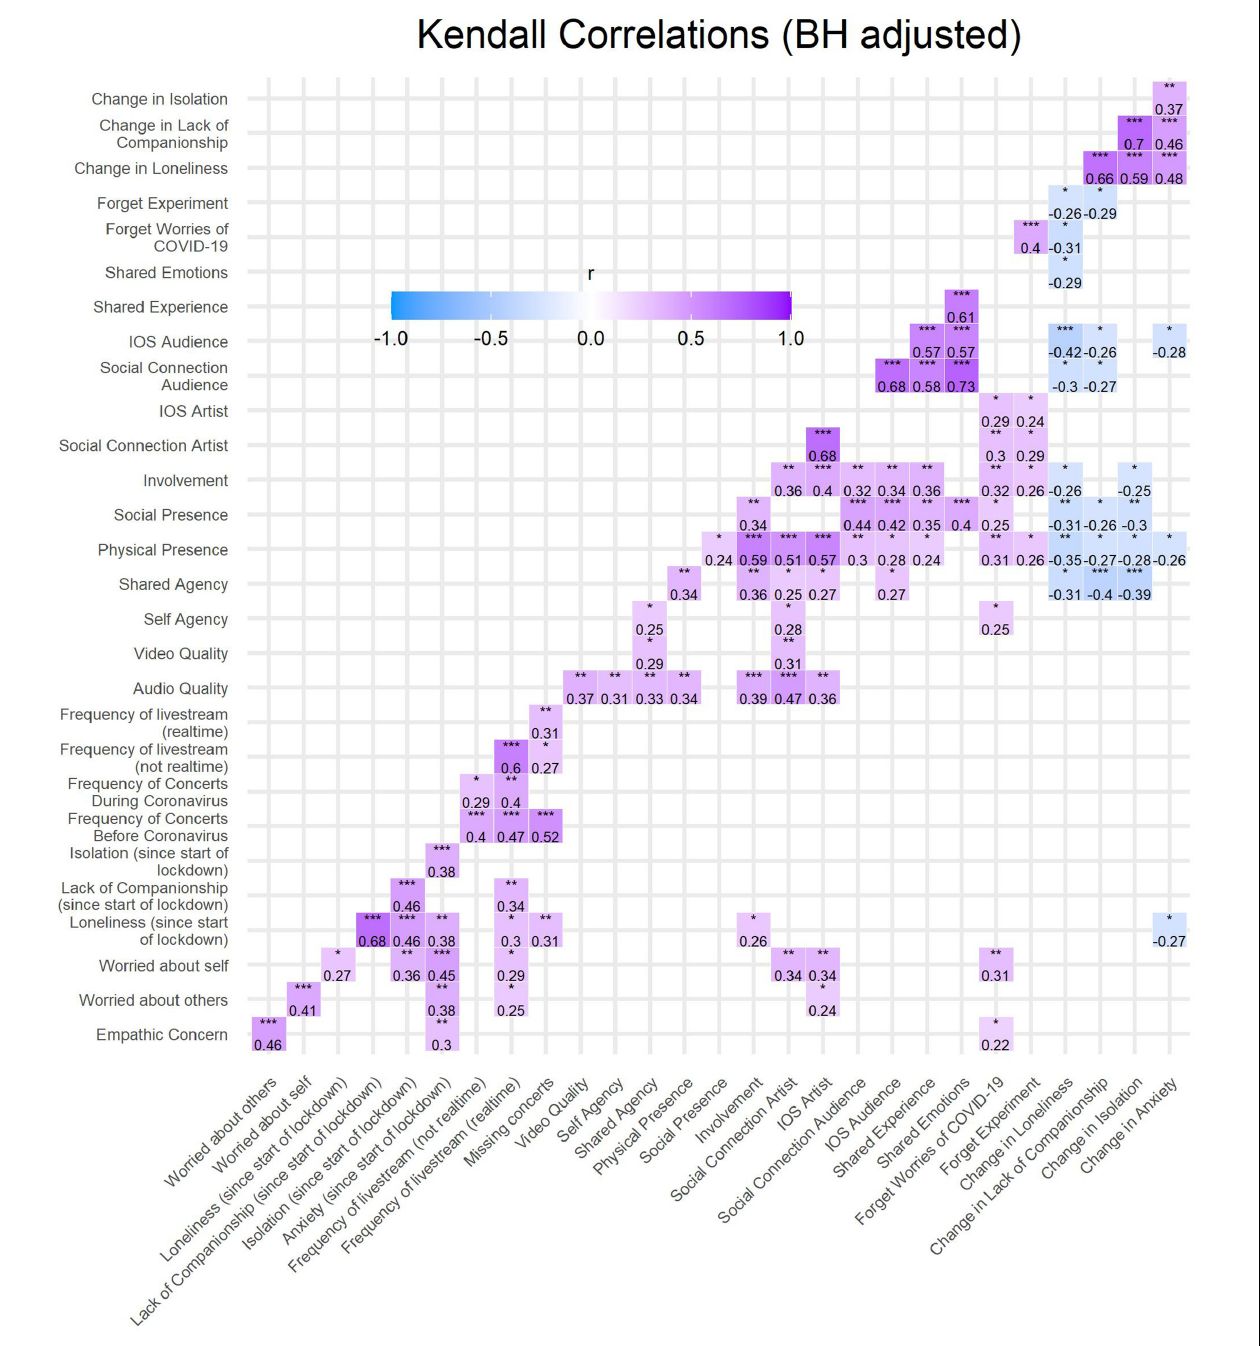
FIGURE 10 | Change in anxiety, isolation, lack of companionship, and loneliness represent questions posed to the audience after each concert where they were asked to what extent they felt these emotions more or less after the concert (1 A lot less – 5 A lot more). Therefore, for example, participants tended to feel less lonely, less lack of companionship, and less isolation when they experienced more social and physical presence, and more physical presence was also associated with less anxiety. Forget experiment represents the item inquiring if the participant forgot they were participating in an experiment. Frequency of livestream (not realtime) and (realtime) represents the frequency that participants attended virtual concerts in the month prior to their registration for the study. Worried about self and worried about others were measures collected during registration that represent how often participants felt worried for their own well-being or other people during the pandemic, respectively. Variables that did not have any significant correlations (and therefore do not appear in Figure 10 ) include the number of hours listening to music per day, and age.